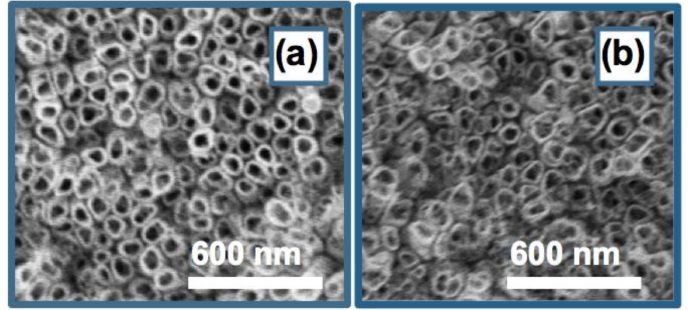
Figure 6. FESEM images of ( a ) ODPA@TNTA and ( b ) PFDPA@TNTA recorded after intense cavitation by ultrasonication in water for 10 min followed by additional 60 min.